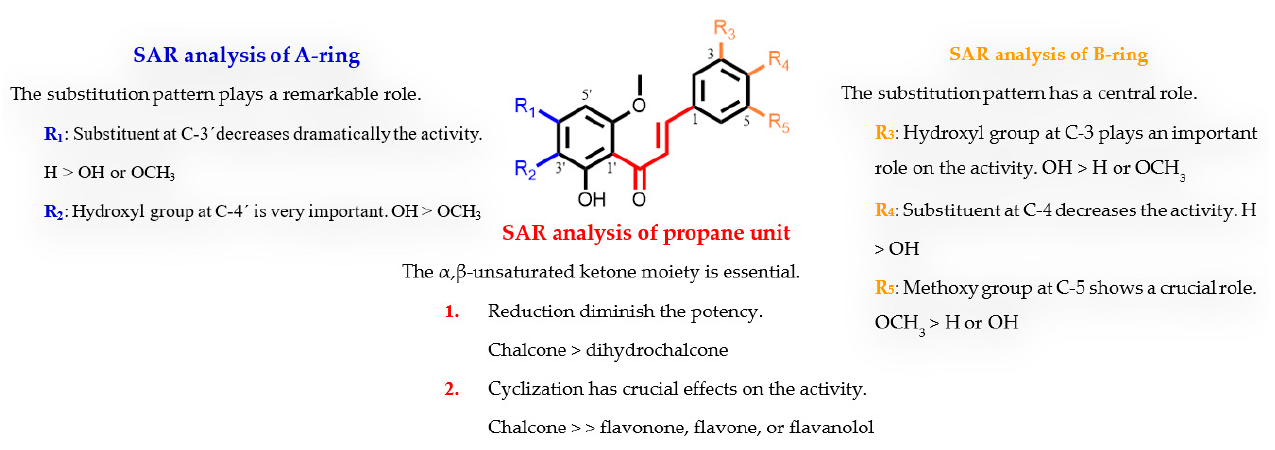
Figure 3. Overview of the structural requirements of flavonoids as potential giardicidal agents.